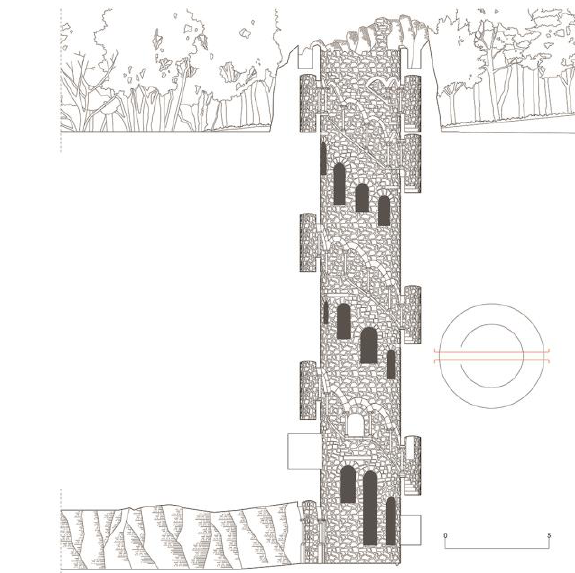
Figure 11 . The Quinta da Regaleira in Sintra, the Poço Iniciatico , cross